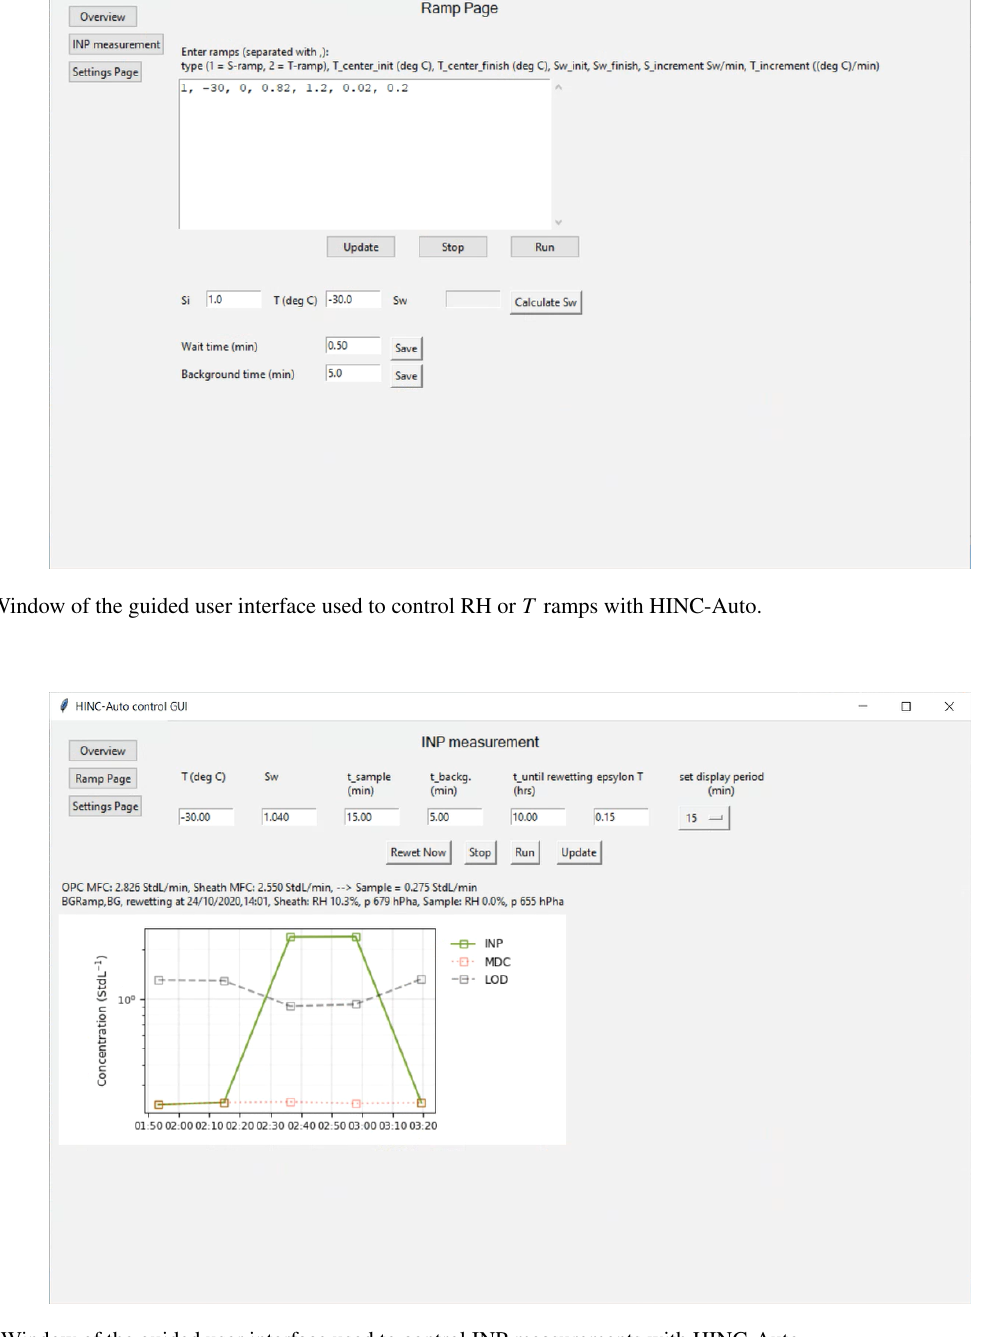
Figure A10. Window of the guided user interface used to control INP measurements with